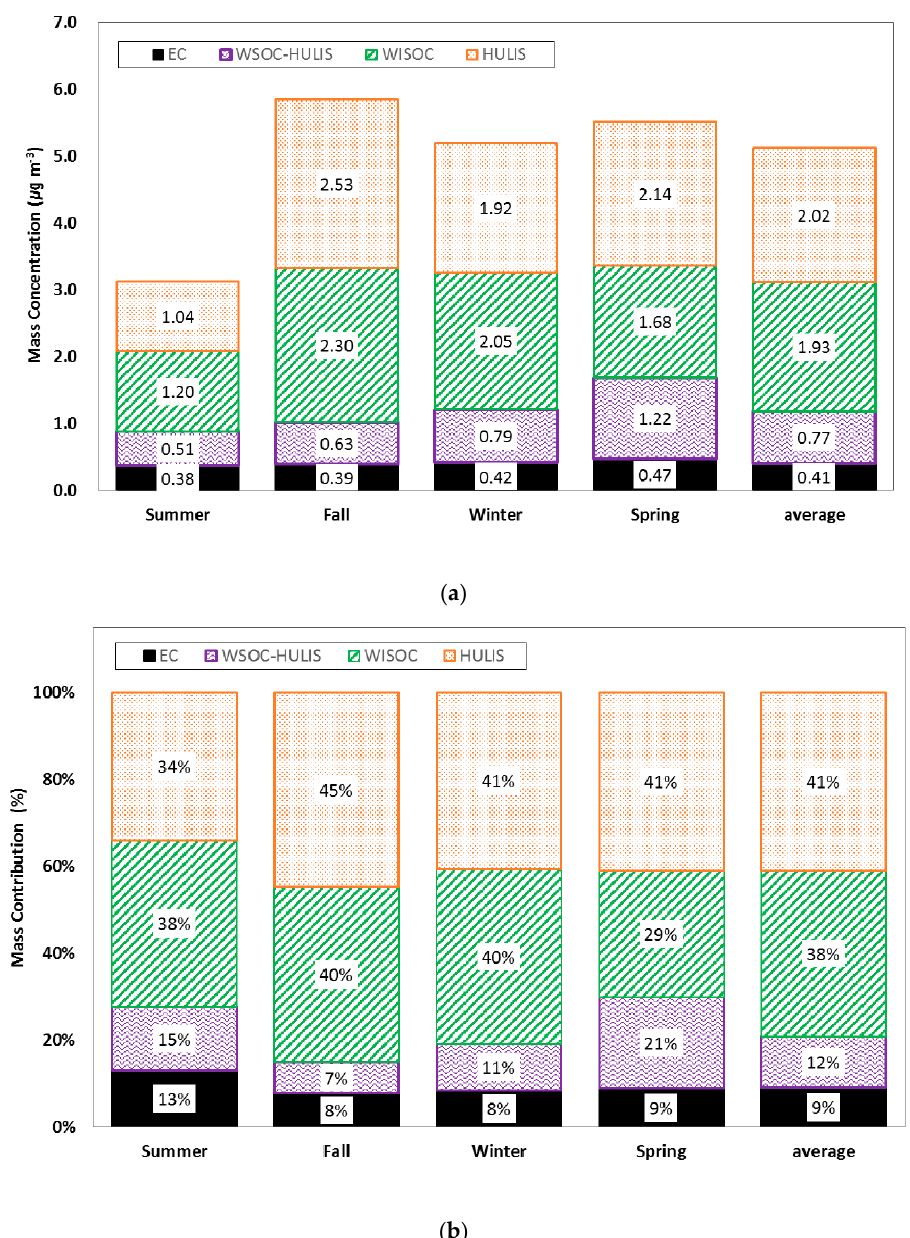
Figure 1. Seasonal variation of the concentrations of carbonaceous species in PM 2.5 measured at Anmyeon Station. ( a ) Seasonal average mass concentration; and ( b ) relative fractions of WSOC (Water Soluble Organic Carbon), WISOC (Water Insoluble Organic Carbon), EC (Elemental Carbon), and HULIS (HUmic LIke Substances).